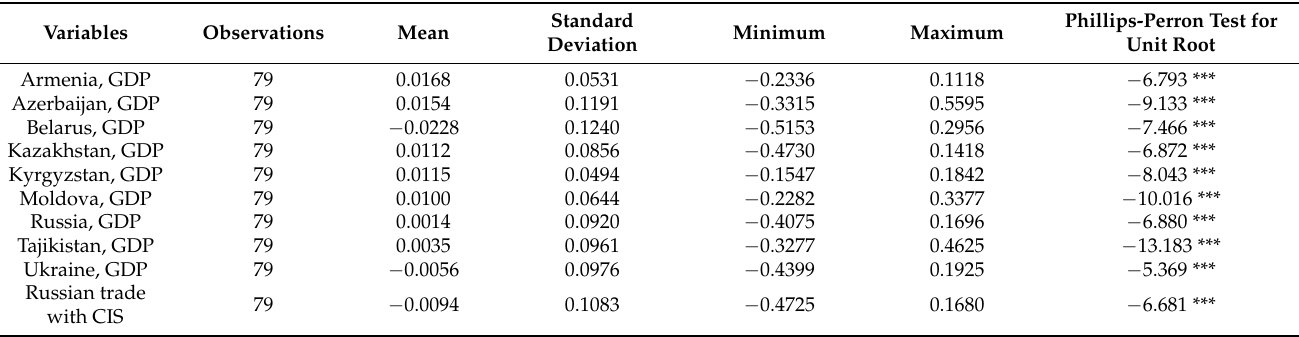
Table 5. Logarithmic Difference of Quarterly Data.